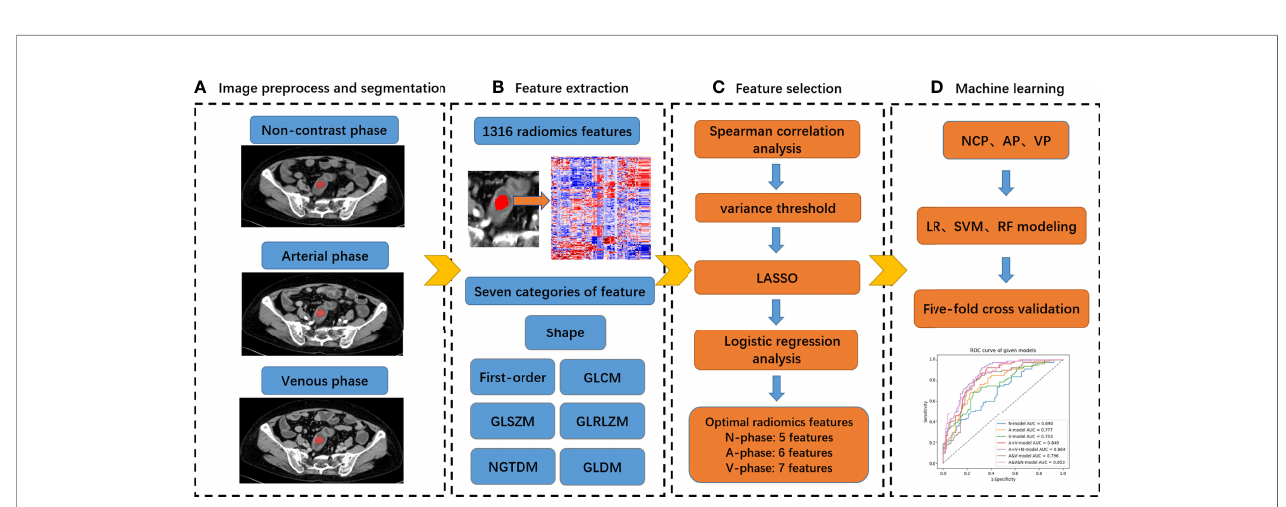
FIGURE 1 | Different CT-phase images used for radiomics analysis. (A – C) Images before the preprocessing of non-contrast phase, arterial-phase, and venous- phase. (D – F) Images after the preprocessing and delineated along the contour of tumor on the largest slices of